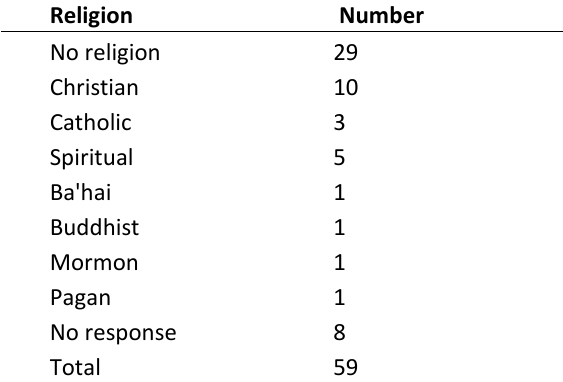
Table 4. Self-identified religious